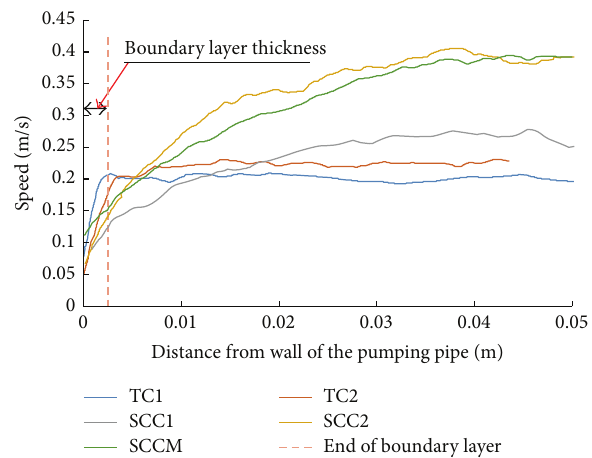
Figure 1: Speed profile of different types of concretes as discussed by Le